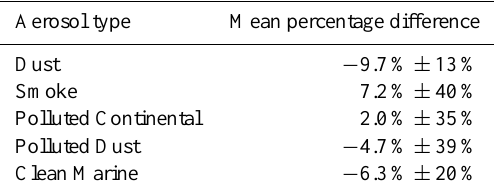
Table 6. Mean percentage lidar ratio difference between the S AC calculation and the CALIOP modeled value S CALIOP , 532 for each of 20 consecutive 5km horizontal resolution profiles.